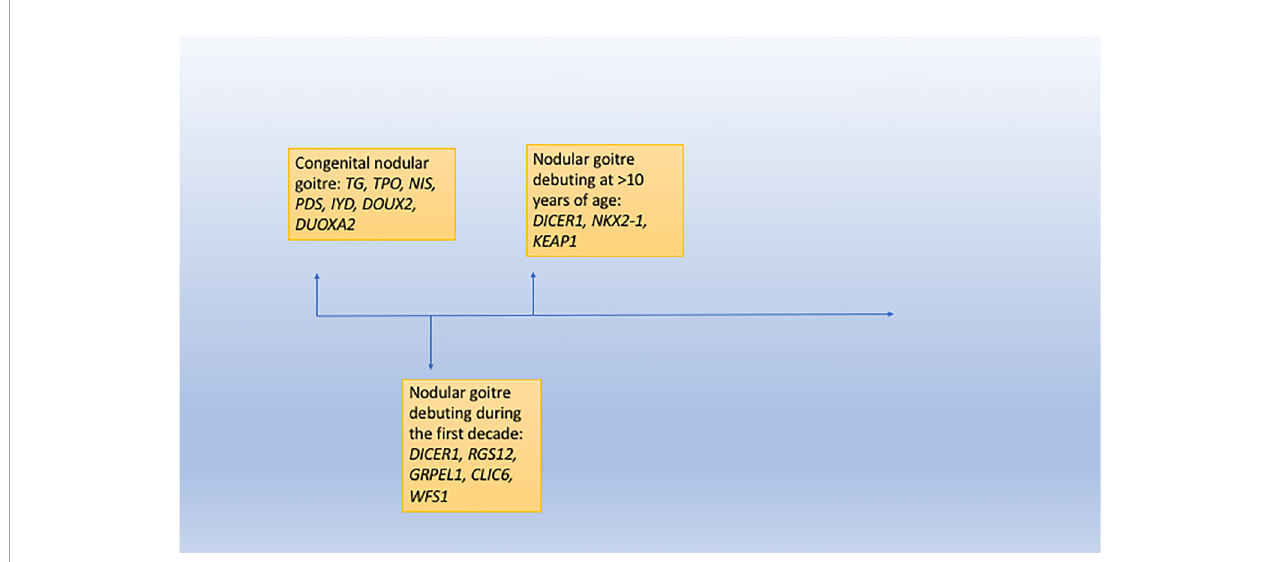
FIGURE 2 | A fl owchart showing age at nodular goitre diagnosis and the putative causative